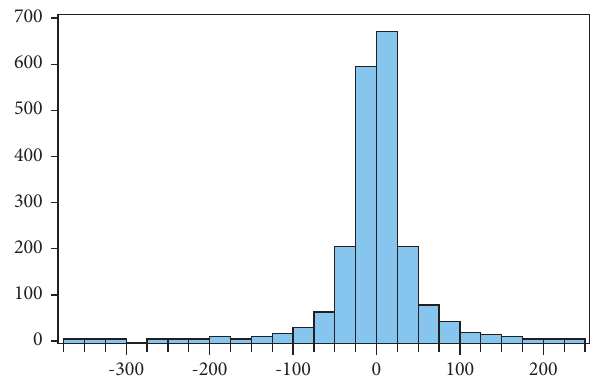
Figure 1: Return characteristics of A-share market composite index.